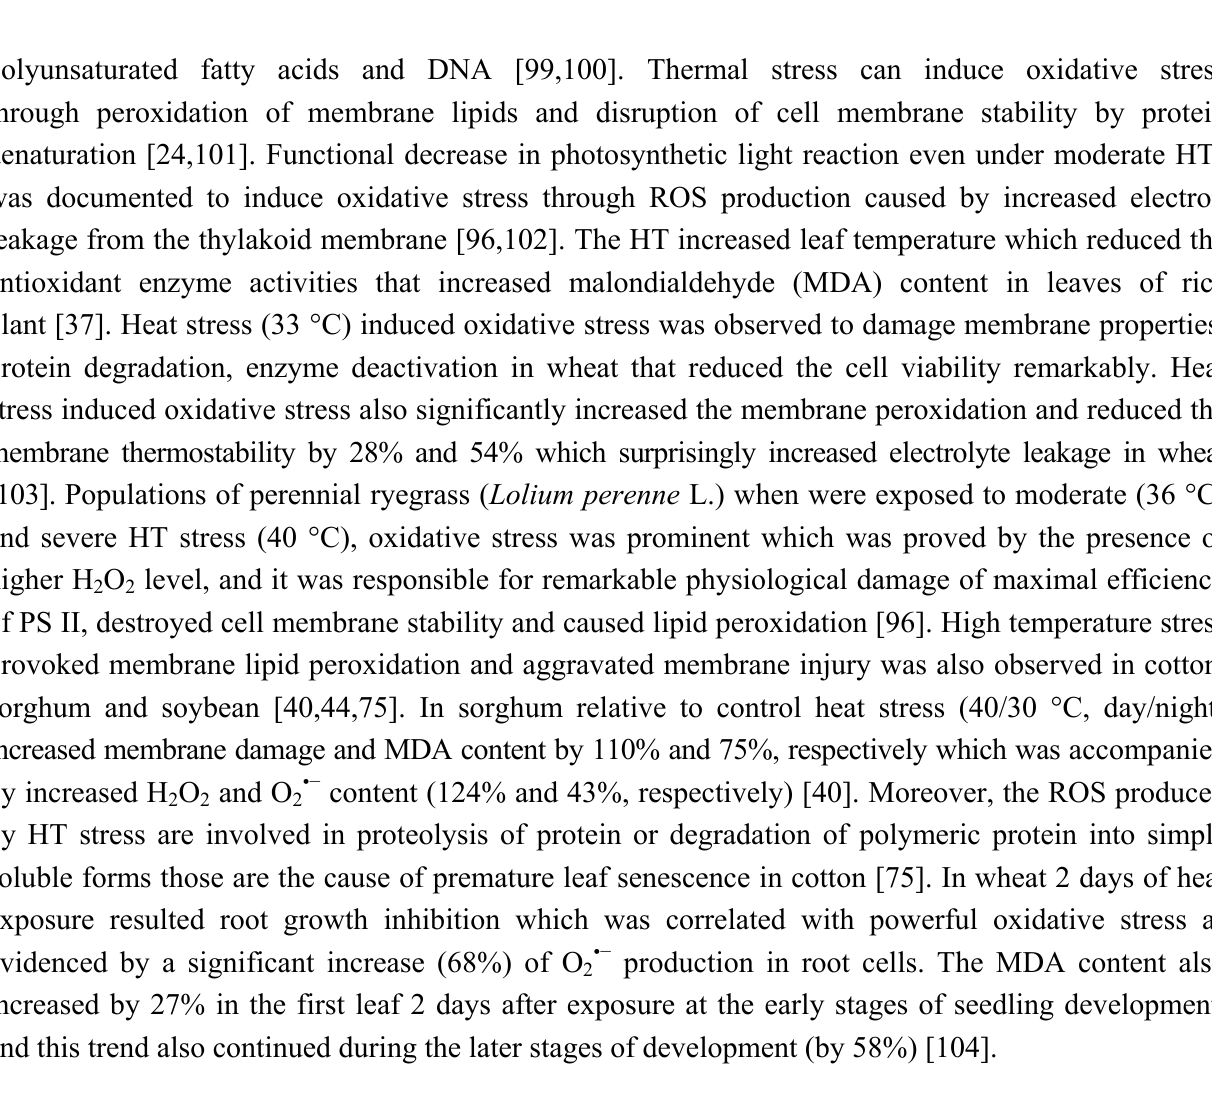
Figure 2. Sites of production of reactive oxygen species in plants